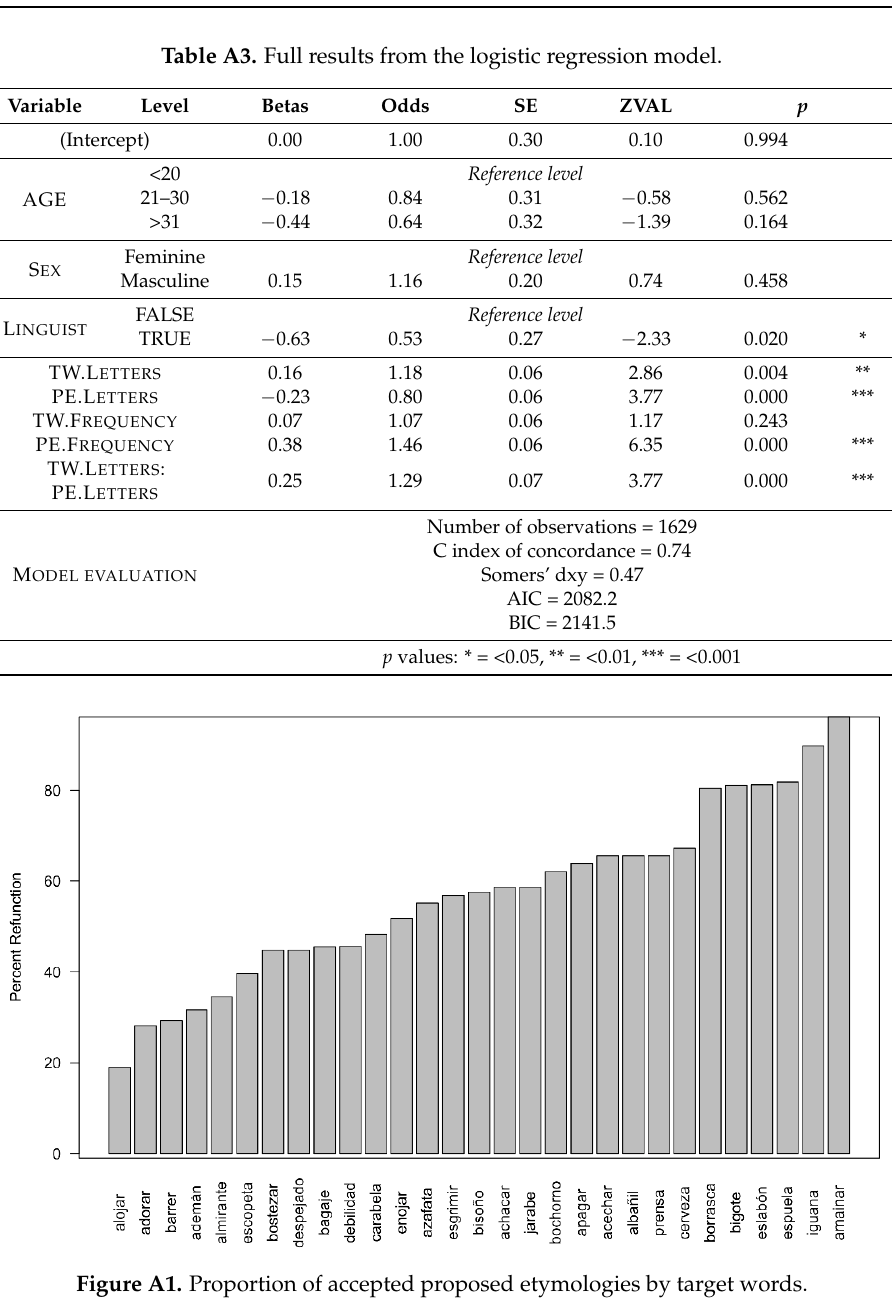
Figure A1. Proportion of accepted proposed etymologies by target words.